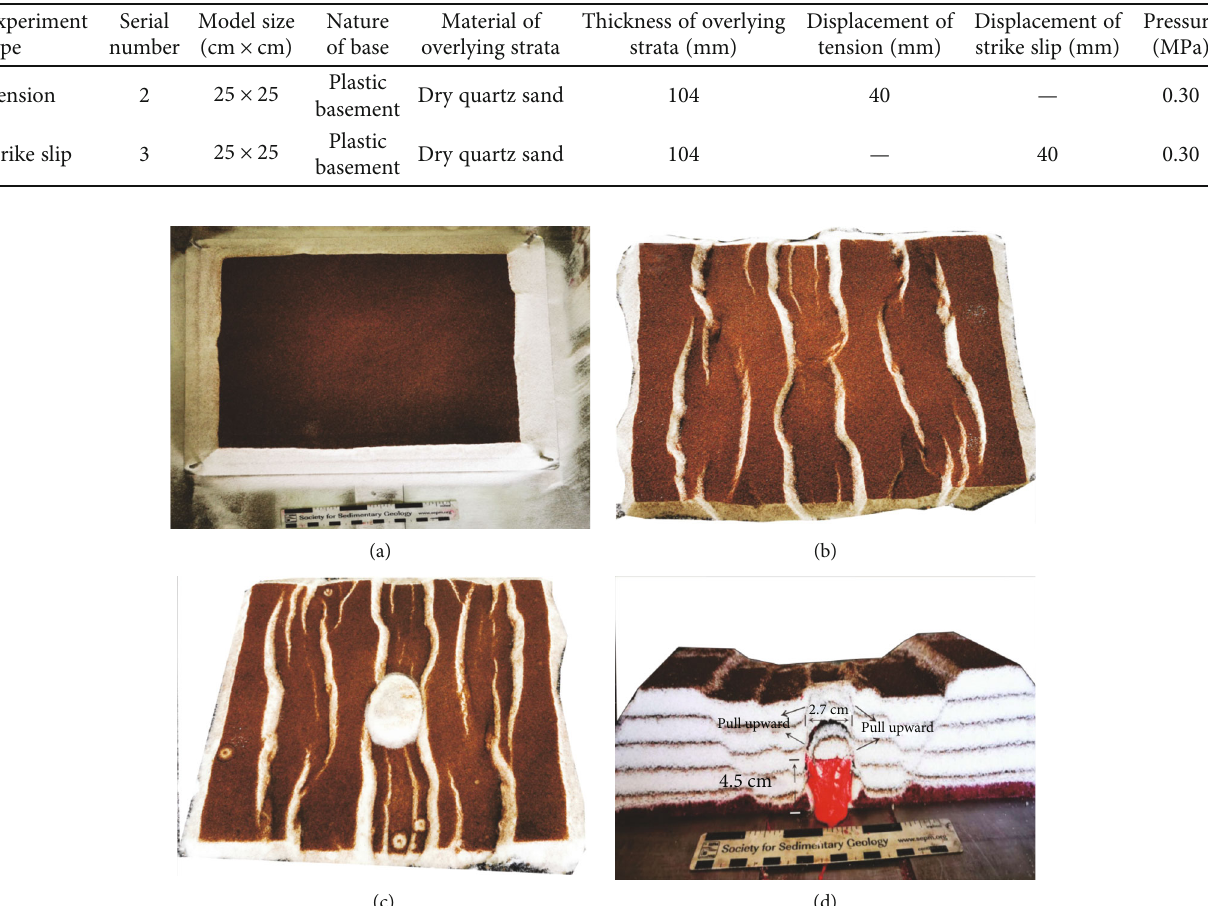
Table 4: Experimental parameters and record results of the tension and strike-slip group.